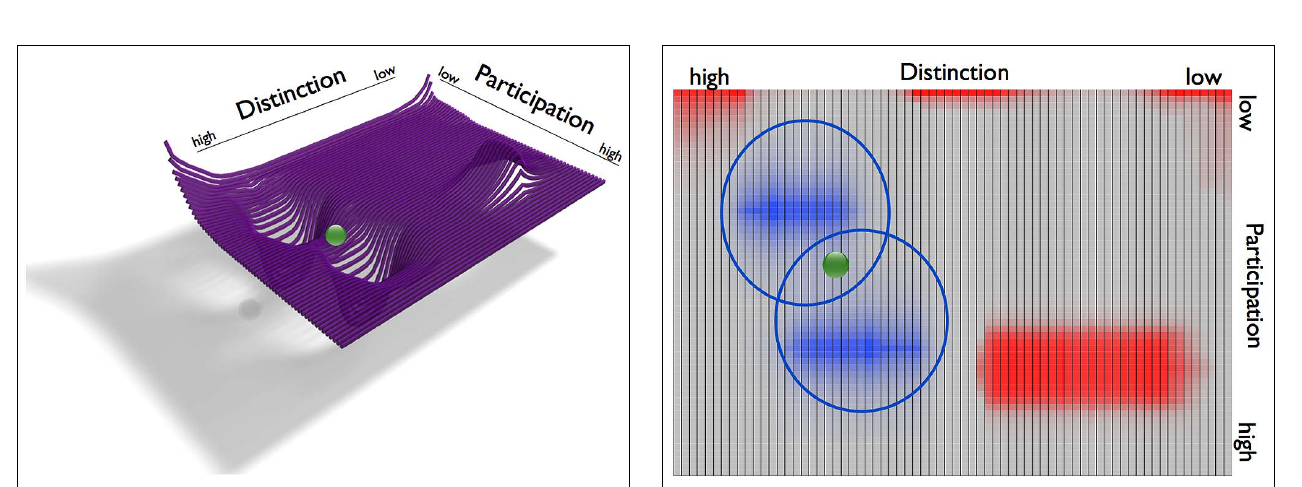
symbolized as locations of red and blue balls.The attractors are wells in the D / P landscape, into which the self systems (balls) tend to move. Arrows indicate trajectories from two arbitrary starting points.